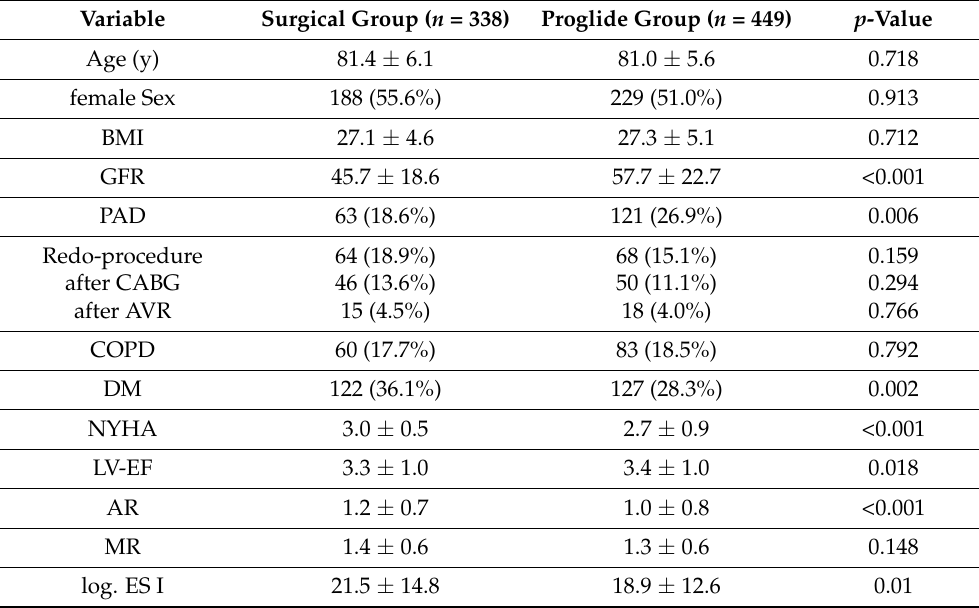
Table 1. Baseline characteristics.